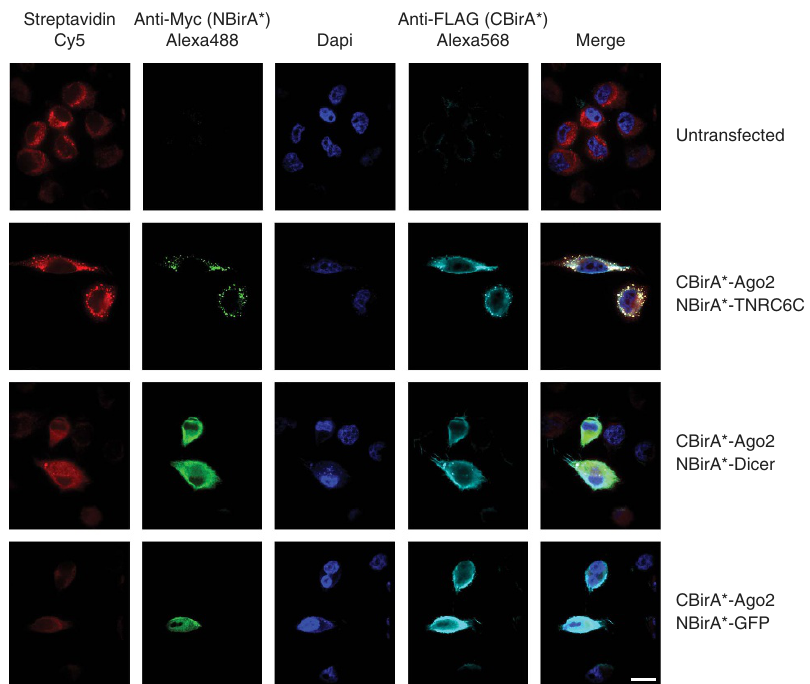
Figure 6 | Localization of the fusion proteins used for the Cdc25C/14-3-3 e split-BioID. Immunofluorescence of transiently expressed constructs by Myc- and FLAG-tag detection as well as the detection of biotinylated proteins by Cy5-coupled streptavidin. Scale bar, 15 m m. All constructs are expressed in the cytosol and have the chance to interact with each other.